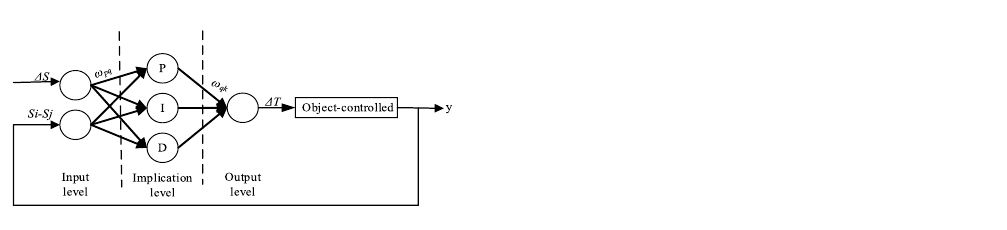
Figure 5. Structure of the